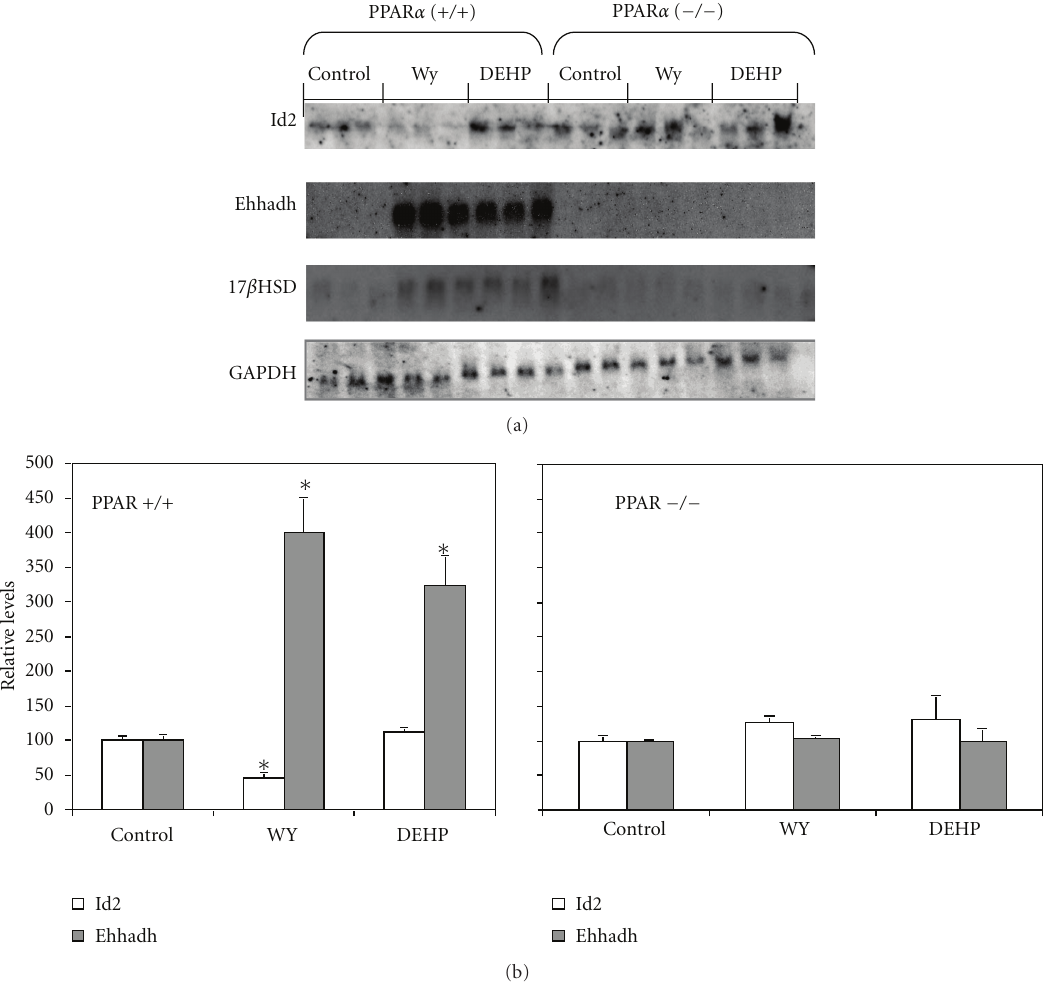
Figure 2: Downregulation of Id2 gene expression by WY is dependent on PPAR α . Wild-type SV129 mice (+/+) or SV129 mice that lack PPAR α ( − / − ) were fed a control diet ( Control ) or a diet containing WY (0.1%) or DEHP (0.6%) for 3 weeks. Total RNA isolated from liver was separated by 1.2% agarose, transferred to nylon, and analysed by northern blot using probes for Id2, Ehhadh, and 17 β HSD, and GAPDH as a control. Northern autoradiograms (a) were densitometrically scanned and expression normalized to that of GAPDH (b). Each value represents the mean ± standard error of three animals. ∗ significantly di ff erent from control ( P < 0 .